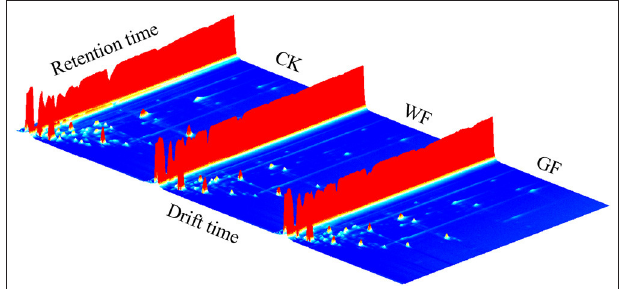
FIGURE 1 | 3D topographical visualization of raw milk from cows fed different diets. CK, basal diet (cows were not fed flaxseed); WF, whole flaxseed (dairy